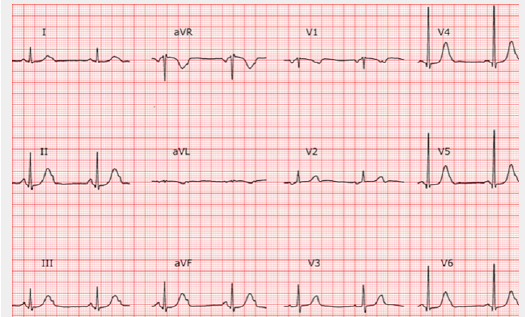
One ECG from the survey. Description and MCQ are provided before voting. Diagnosis and comments are given after the vote. Description: Basic rhythm: sinus rhythm, regular at 50